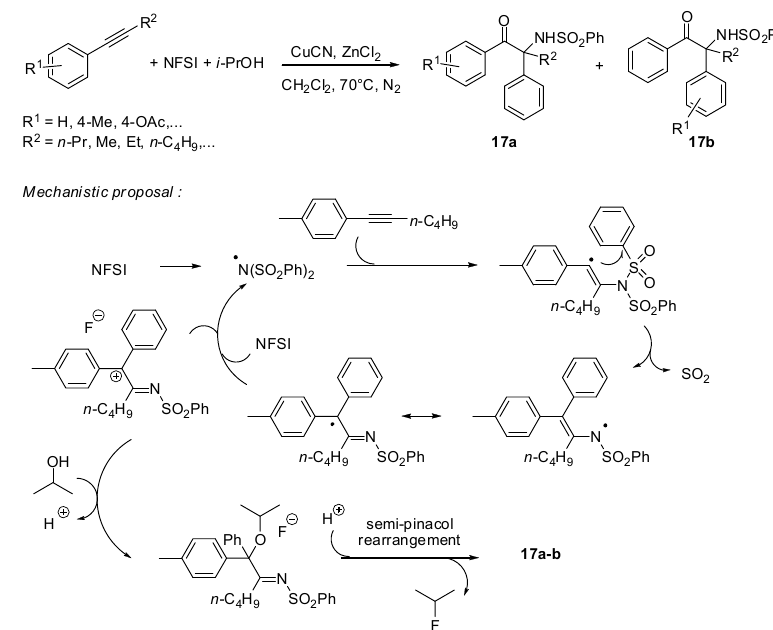
Scheme 15. Multifunctionalization of alkynes with NFSI.